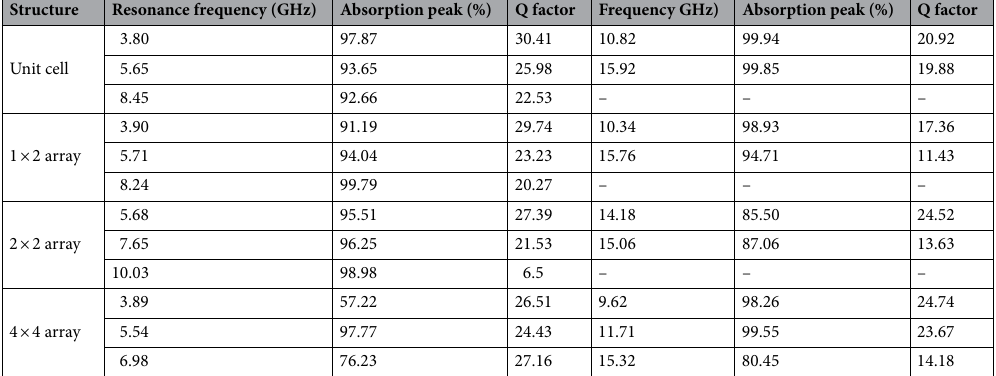
Table 5. Different parameters for various array configuration.